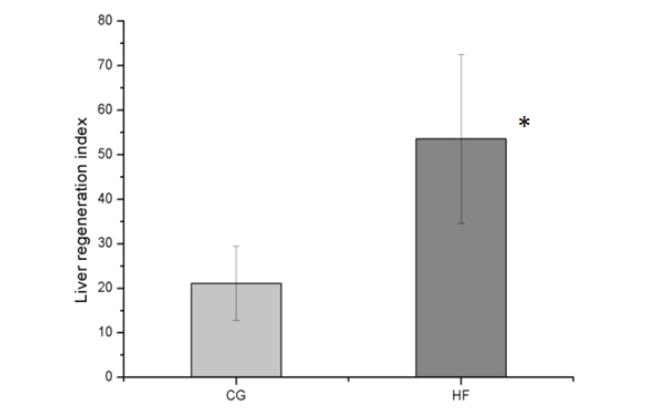
FIGURE 1 - Data presented as means and standard deviation of mean of liver regeneration index. The aqueous extract of Hyptis fructicosa (oral administration during 4 days before surgery) caused a significant increase at this parameter. Liver regeneration was assessed by proliferating cell nuclear antigen (PCNA) 24h after partial hepatectomy. Statistical comparisons among the groups were performed by Mann-Whitney test